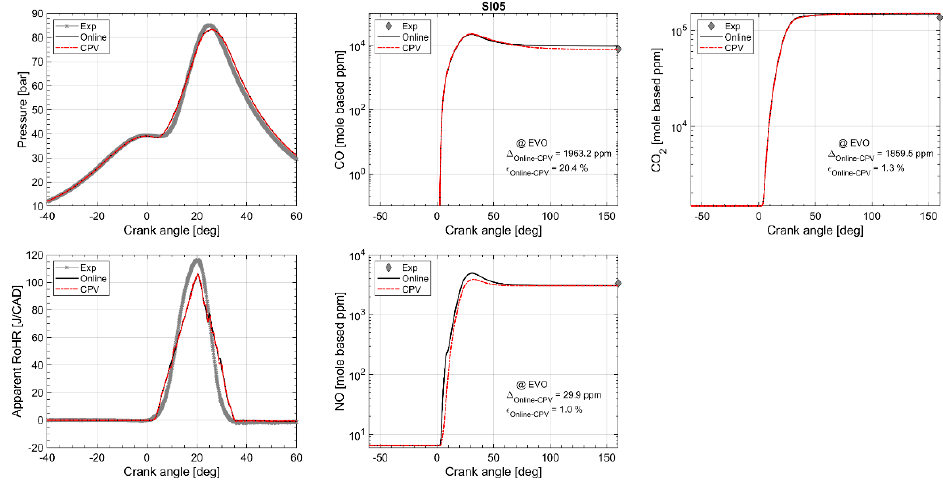
Figure A15. Engine performance and emissions for operating point SI05 (2000 rpm, 20.0 bar IMEP).